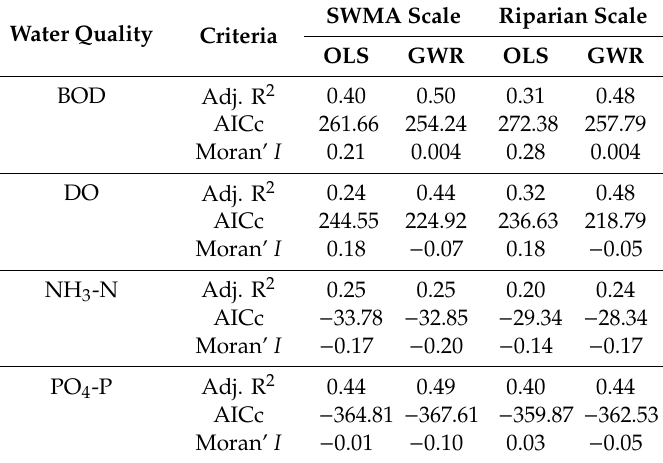
Table6. PerformanceindicatorsofOLSandGWRmodelsatbothscales. ThehighervalueofR 2 andlower values of AICc and Moran’s I (absolute value) indicate better performance of the estimated